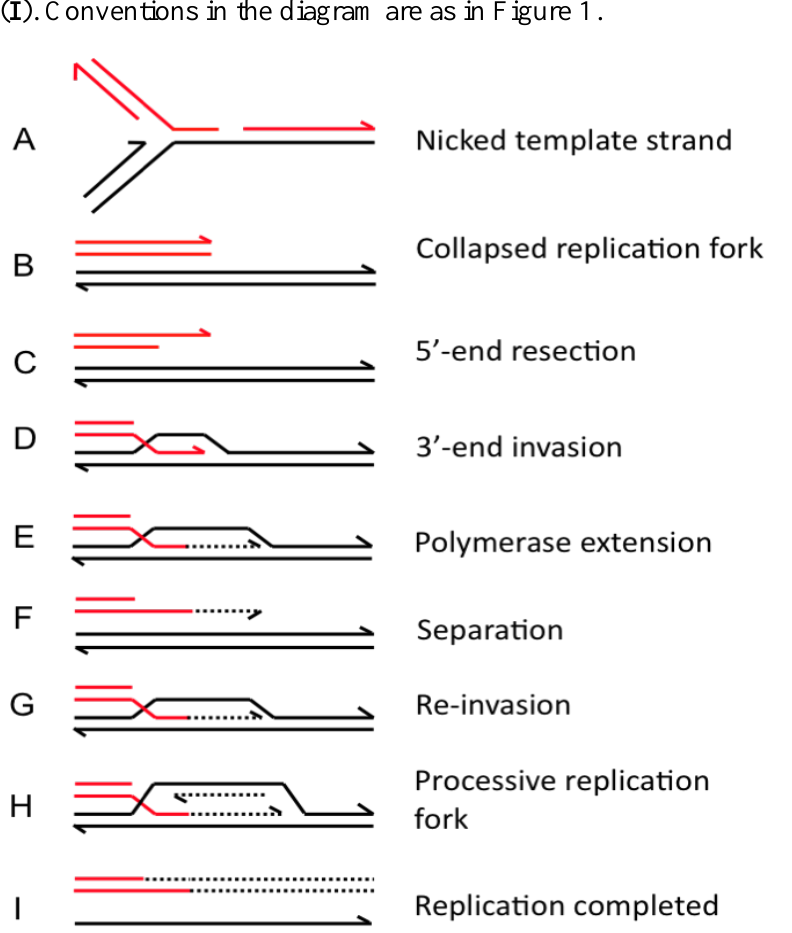
Figure 3. Repair of a collapsed replication fork by break-induced replication